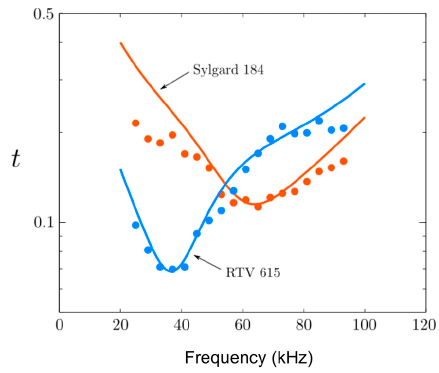
Figure 4. Transmission coefficients. Measurements (full circles) are adjusted by Equation (2) (full lines).